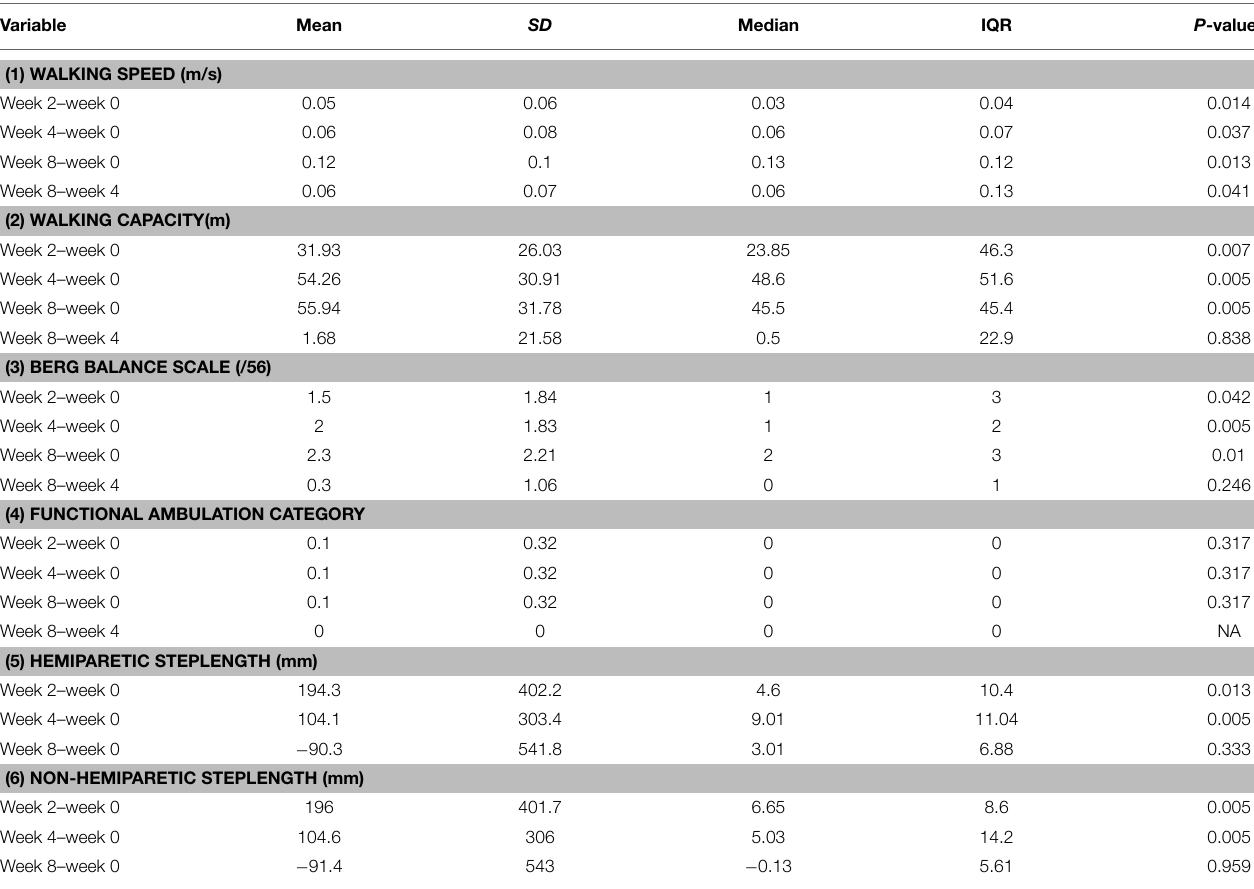
TABLE 2 | Within group differences relative to baseline across time ( N = 10 ). Variable Mean SD Median IQR P